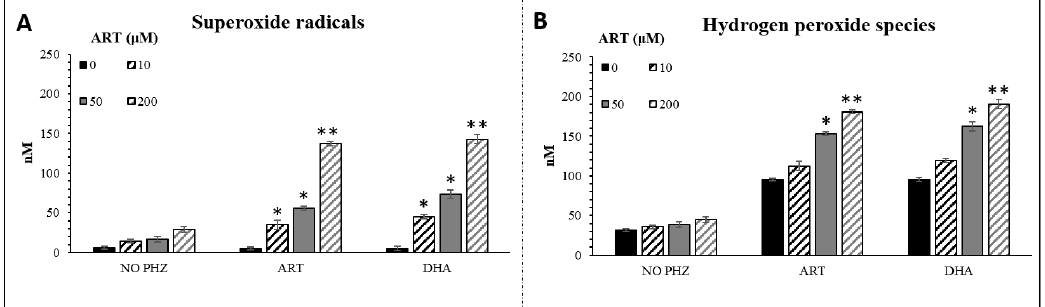
Figure 2. Superoxide radicals ( A ) and hydrogen peroxide ( B ) concentrations deduced from LC-MS analysis in RBCs treated with di ff erent concentrations of PHZ (0.2–1 mM) in fix concentration of DHA and ART (200 µ M). Data are the average ± SD of 5 independent experiments. Significant di ff erences to untreated RBCs at * p < 0.05; ** p < 0.001.